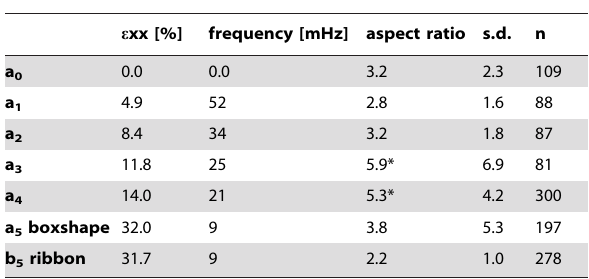
Table 1. Average cell aspect ratios.